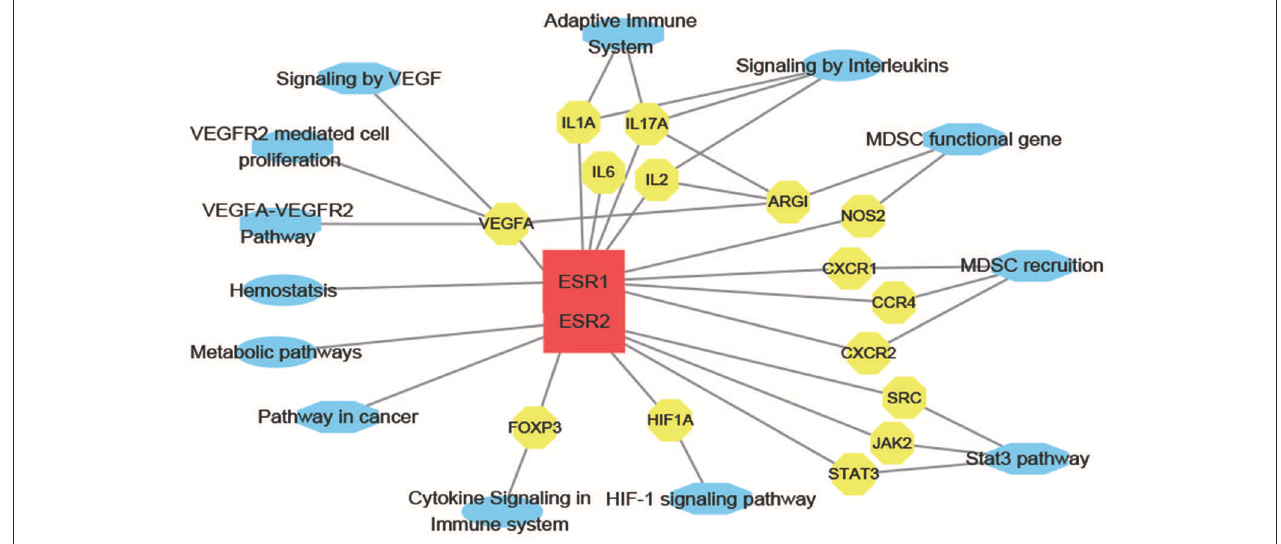
FIGURE 6 | E 2 -target-pathway network. The interaction network has 30 nodes and 39 edges. The red square, yellow circle, and blue ellips, respectively, correspond to E 2 , target proteins and